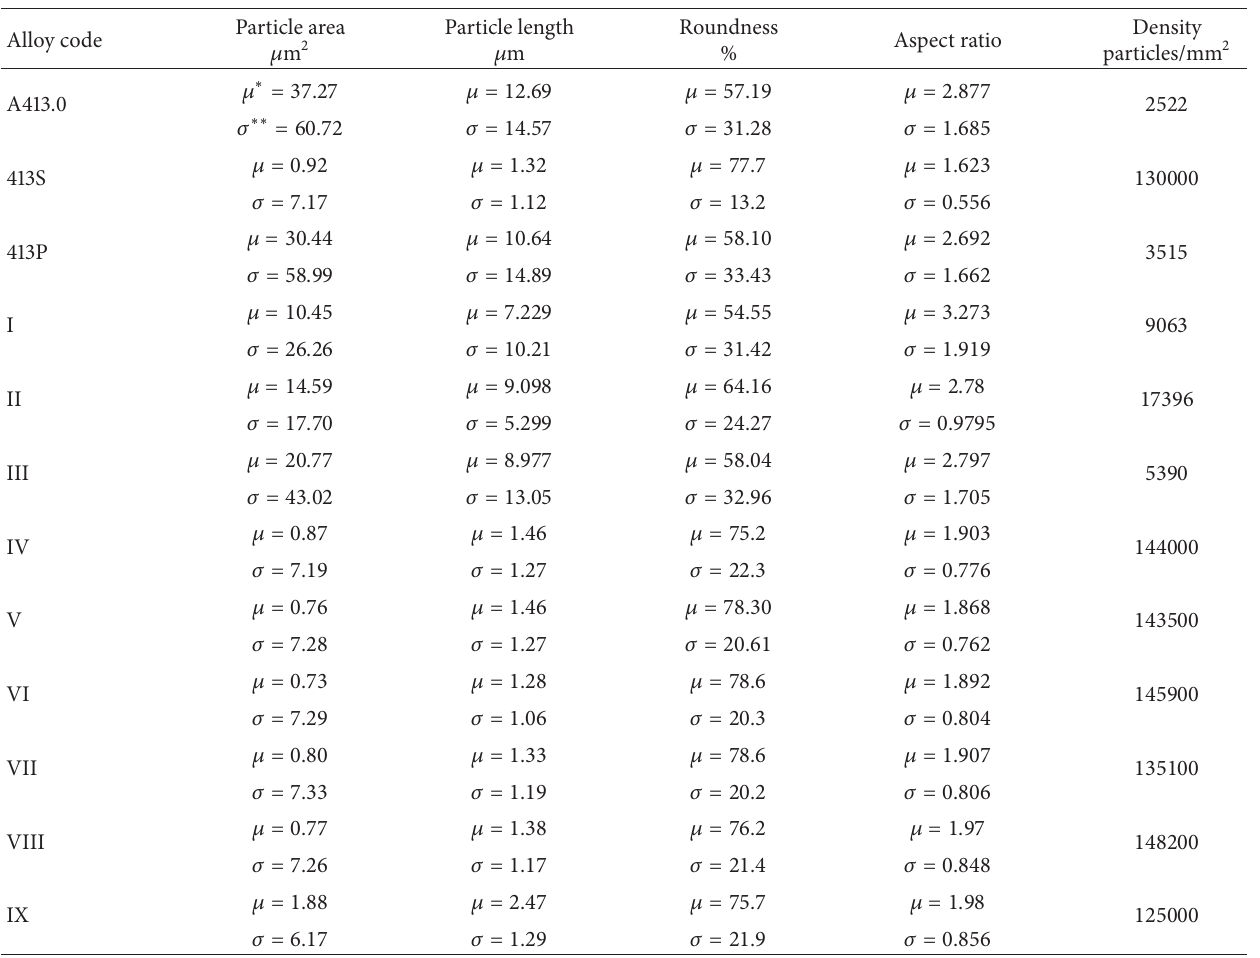
Table 4: Characteristics of the eutectic Si